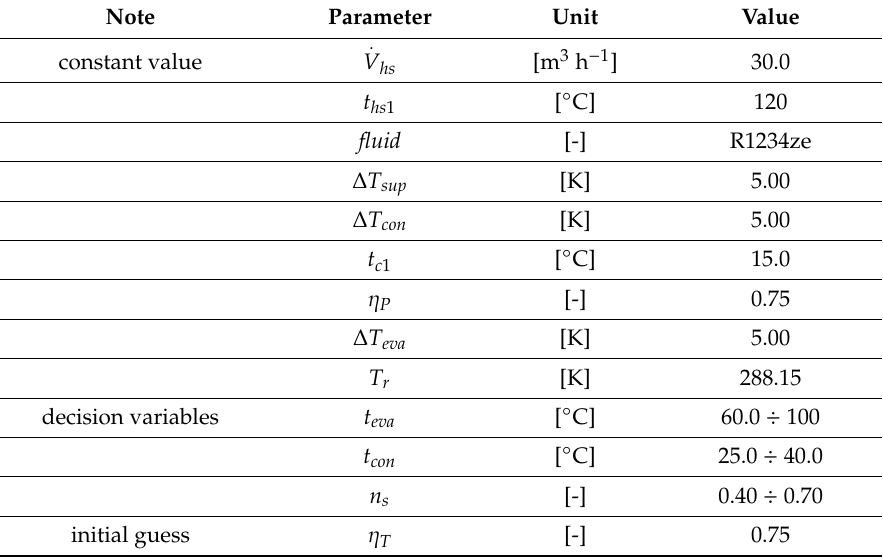
Table 1. Parameters and variables of